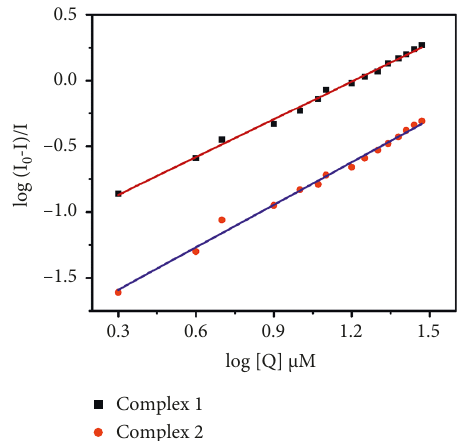
Figure 14: Scatchard plots of log ( I